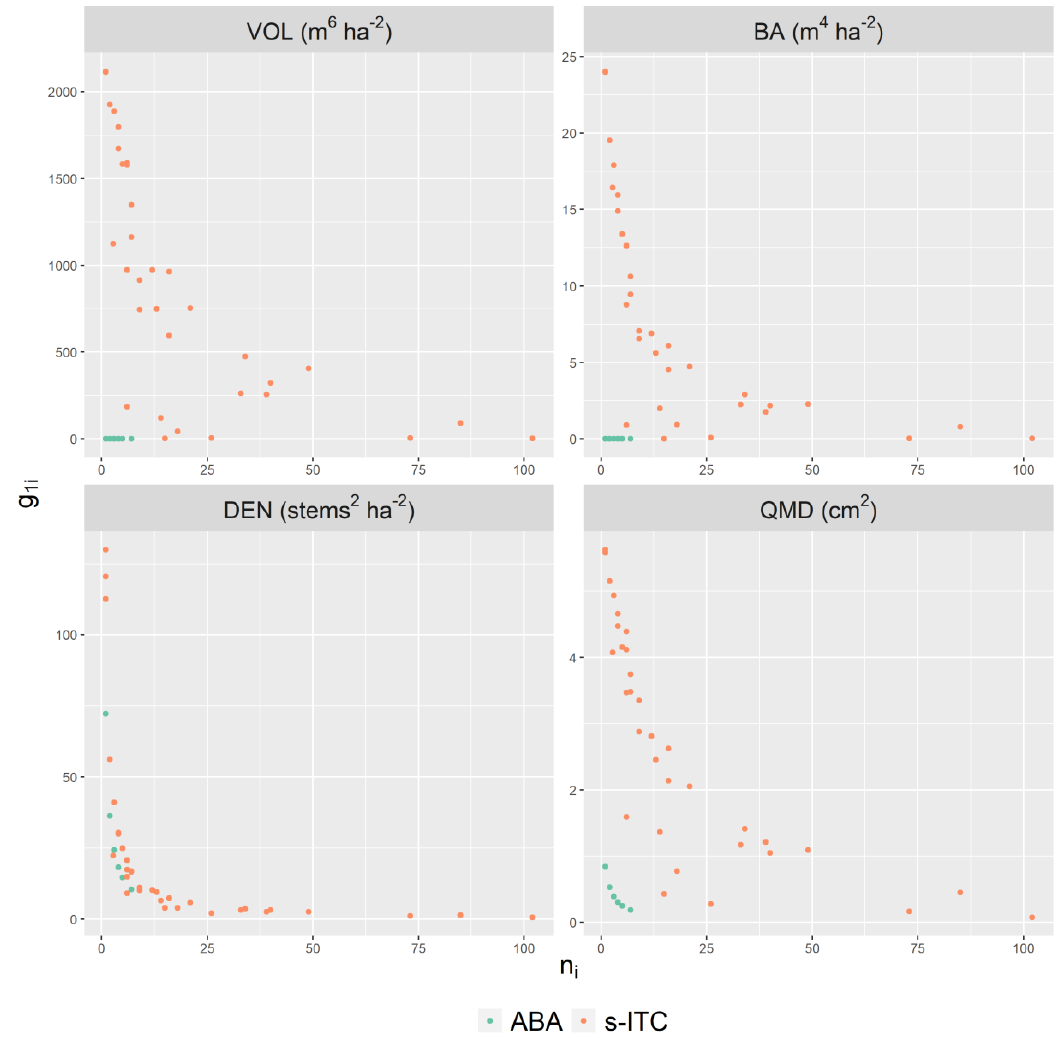
Figure 7. The error component g 1 i for all sampled stands in the study area plotted against the stand-specific sample size n i . Note that g 1 i for unsampled stands, not displayed in this figure, was equal to the respective random effect variance estimate (Table 4).